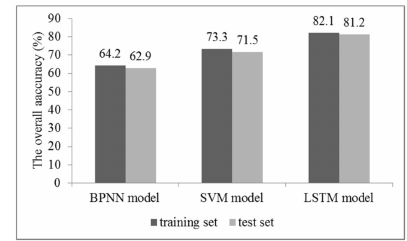
Figure 7. Prediction accuracy of different models (prediction scale: one month).